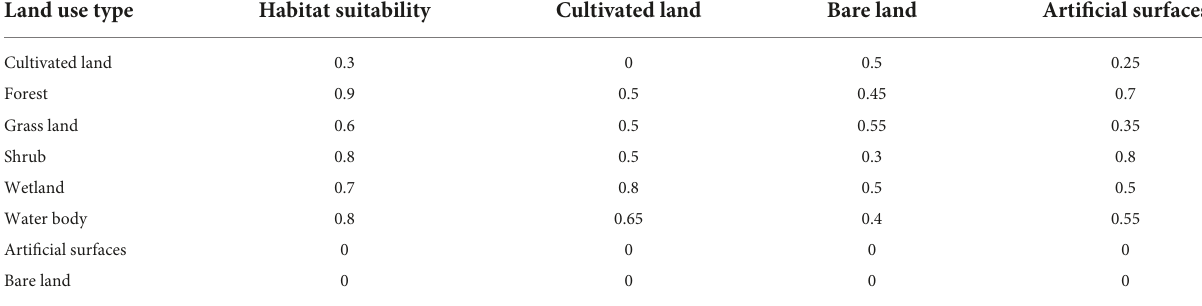
TABLE 2 Sensitivity of different habitats to threat